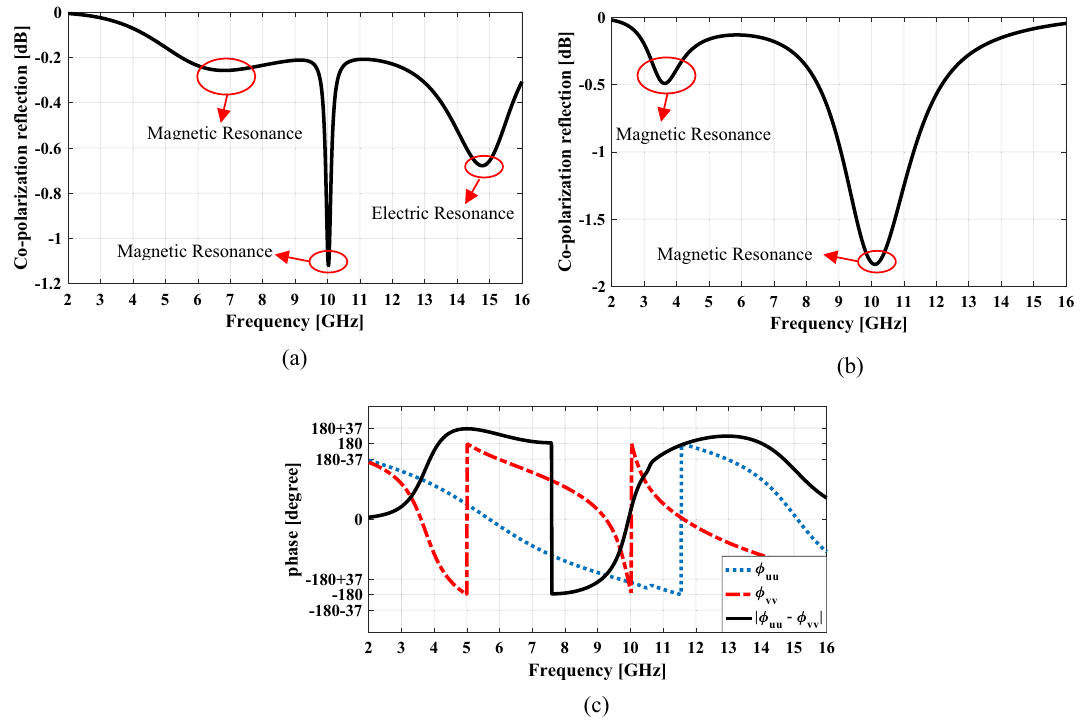
Figure 9. The eigenmodes of the proposed unit cell under normal incidence: ( a ) v-polarized case and ( b ) u-polarized case, ( c ) the phase of reflected wave in u-polarization, v-polarization and the phase difference between